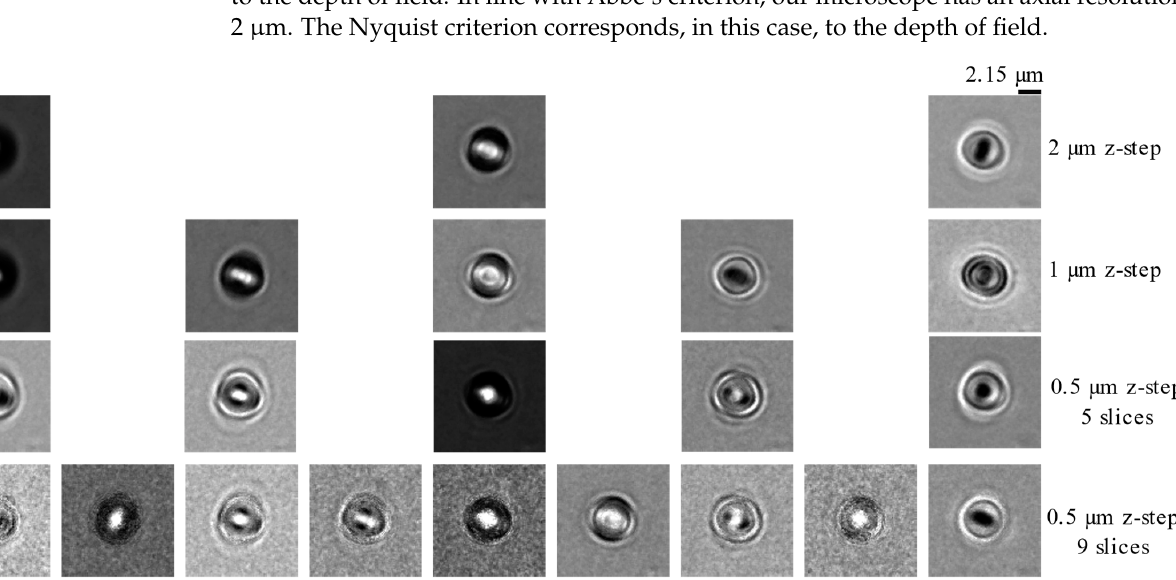
Figure 8. MCR images of RBC with inner earphone shape for different z-steps. 5. Conclusions The MCR analysis of the z-scanning images achieved 3D information recovery in conventional brightfield microscopy. The developed method is an alternative, simple, and cost-effective 3D microscopy technique. In this study, we demonstrated a bilinear relationship between the z-scanning images of brightfield microscopy in the transmission mode and both the specimen layers’ concentrations and spectra. The transmittance mixture images are thus described as MCR data sets. The MCR-ALS analysis under a non- negativity constraint that is commonly used for hyperspectral imaging was applied to four data sets of silica microbeads and RBCs. The images obtained from the MCR analysis demonstrate the proposed method’s ability to perform 3D information recovery through multiplane images deblurring, contrast improvement, and object features enhancement, especially for biological specimen. In comparison with the 3D deconvolution methods, MCR analysis produces better results, showing that it can be an alternative to 3D